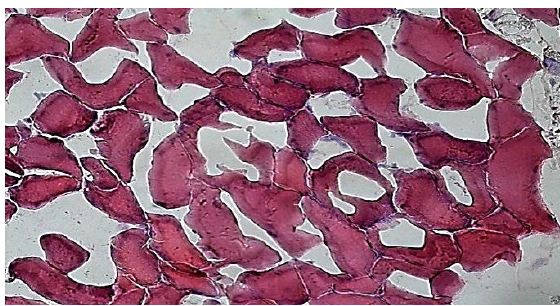
Fig. 2. Striated muscle tissue of the control samples of the refrigerated pork neck on the bone packed using MAP after 10 days of storage.